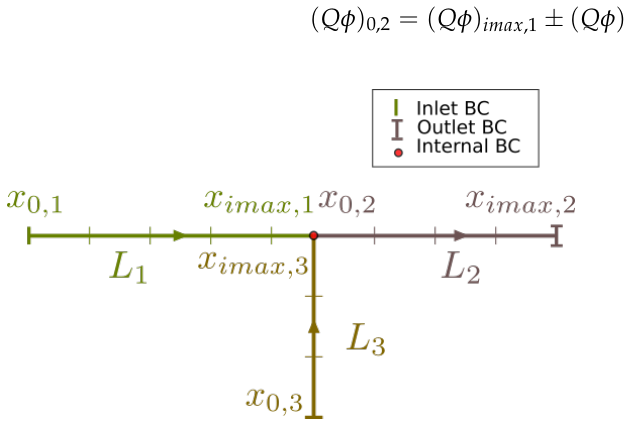
Figure 1. Spatial domain of